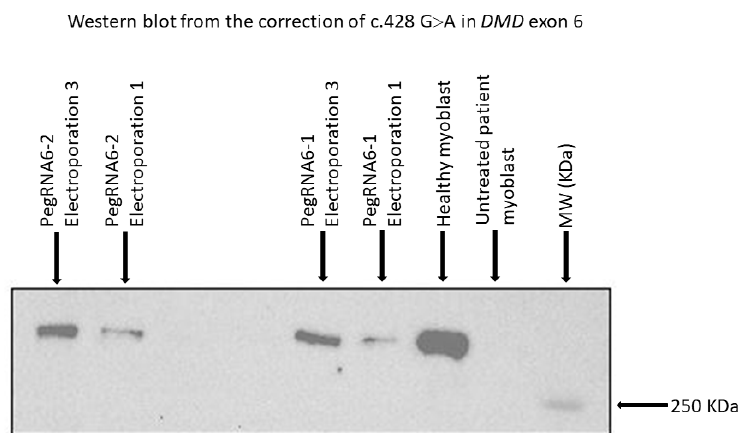
Figure 10. Western blot results from repetitive treatments (electroporations 2 and 3) showing dys- trophin expression with pegRNA6-1 and pegRNA6-2. Ctrl+ and Ctrl- indicate, respectively, positive results (myoblasts without a DMD mutation) and negative controls (untreated DMD myoblasts used for the correction using prime editing).